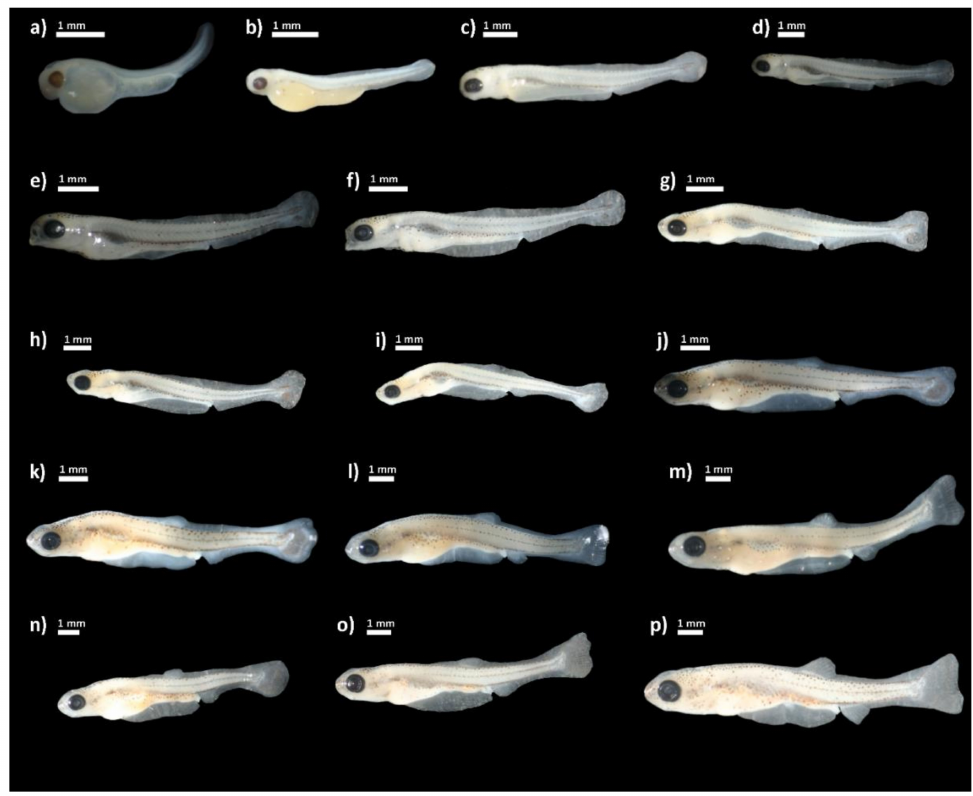
Figure 2. Delminichthys krbavensis : ( a ) upon hatching; ( b ) day 4 post-hatching (PH); ( c ) day 7 PH; ( d ) day 9 PH; ( e ) day 11 PH; ( f ) day 14 PH; ( g ) day 18 PH; ( h ) day 21 PH; ( i ) day 23 PH; ( j ) day 25 PH; ( k ) day 28 PH; ( l ) day 32 PH; ( m ) day 36 PH; ( n ) day 39 PH; ( o ) day 44 PH; ( p ) day 48